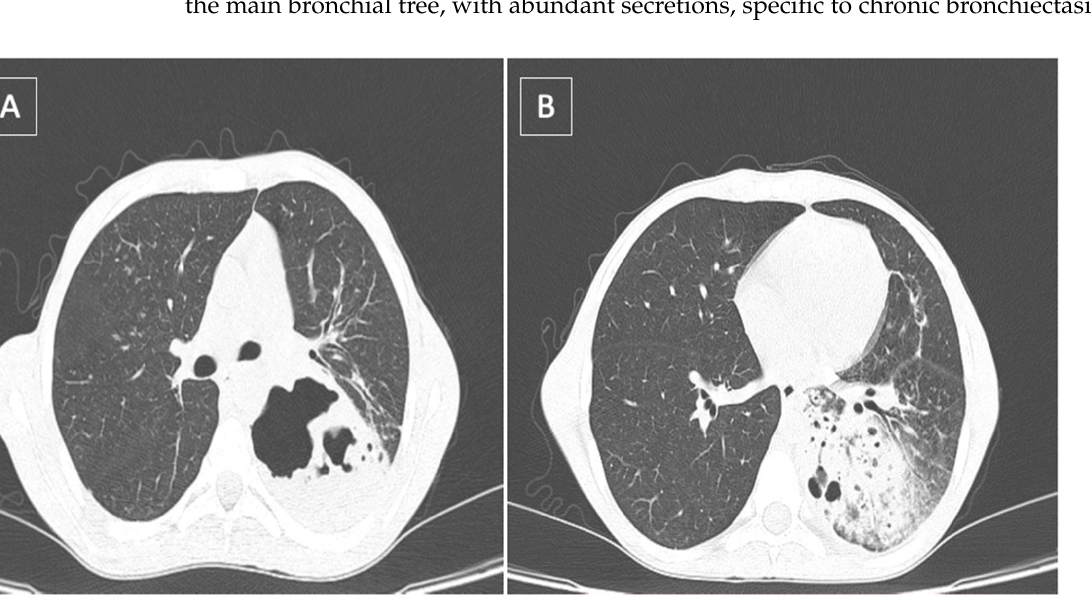
Figure 1. Thoracic CT scan showing: ( A ) lung abscess located in the left lower lobe; ( B ) presence of the left lower consolidation with air bronchogram and perilesional ground glass opacities.